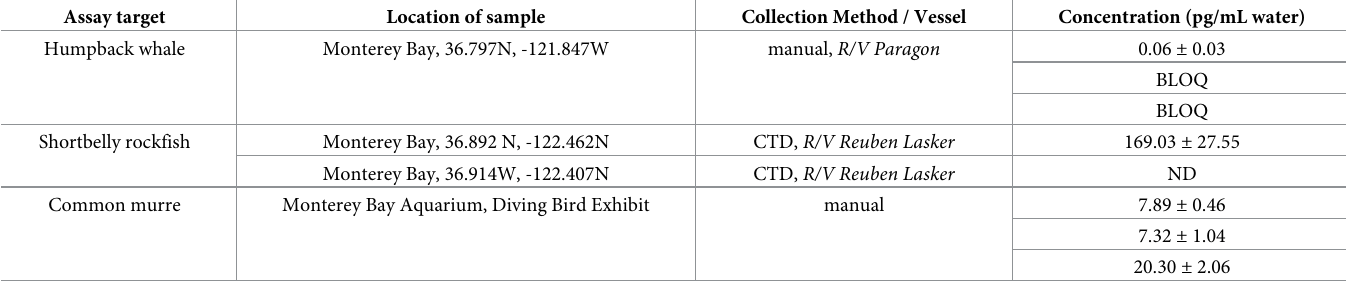
Table 5. Results of environmental samples tested for each assay. ± is 95% confidence interval. “BLOQ” represents below the limit of quantification. “ND” represents non-detect, meaning sample was not assigned a C q value. Assay